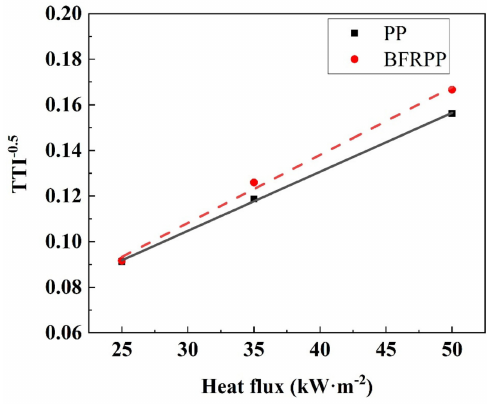
Figure 13. The relationship between the reciprocal of square root of TTI and heat